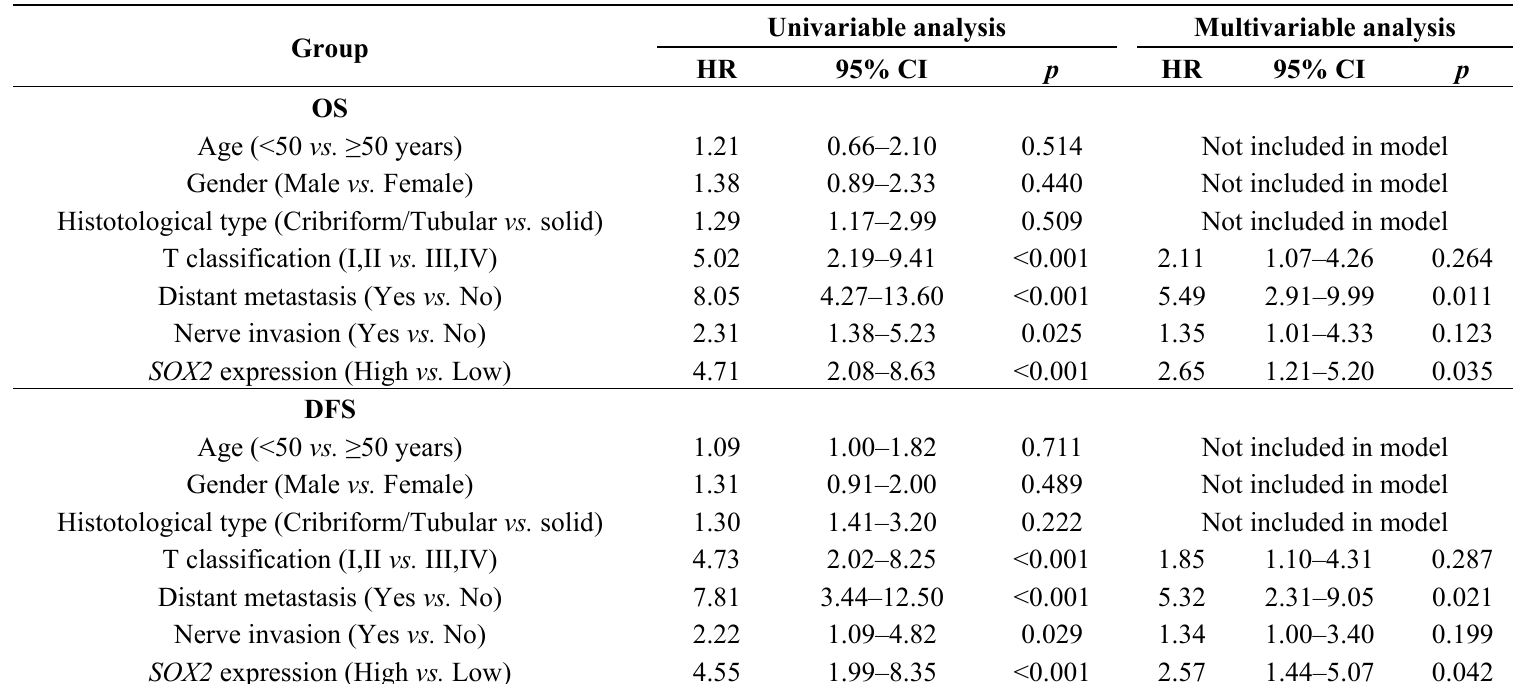
Table 2. Univariable and multivariable analysis of ACC survival using Cox’s proportional hazards model. Univariable analysis Multivariable Group